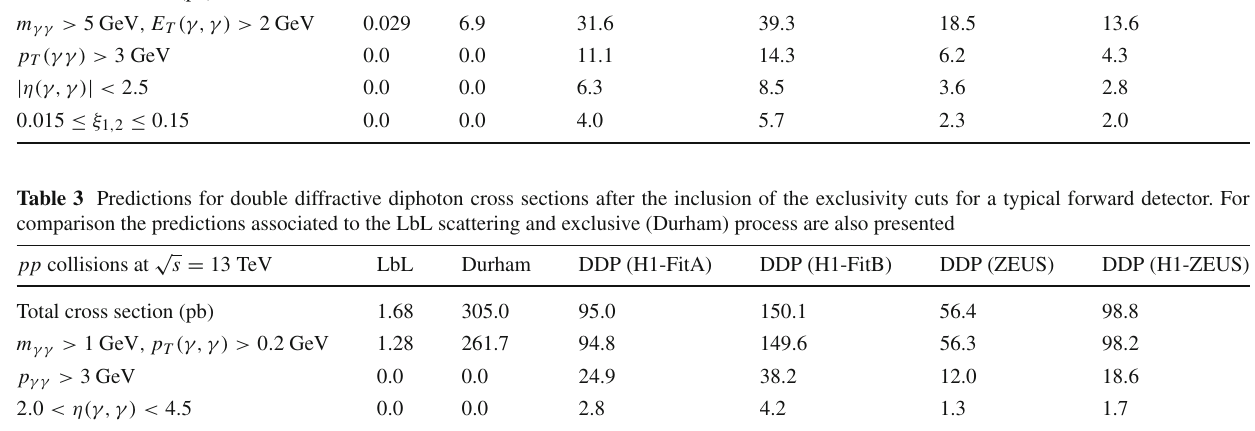
Table 2 Predictions for the double diffractive diphoton cross sections after the inclusion of the exclusivity cuts for a typical central detector. For comparison the predictions associated to the LbL scattering and exclusive (Durham) process are also presented √ pp collisions at s = 13 TeV LbL Durham DDP (H1-FitA) DDP (H1-FitB) DDP (ZEUS) DDP (H1-ZEUS) Total cross section (pb) 1.68 305.0